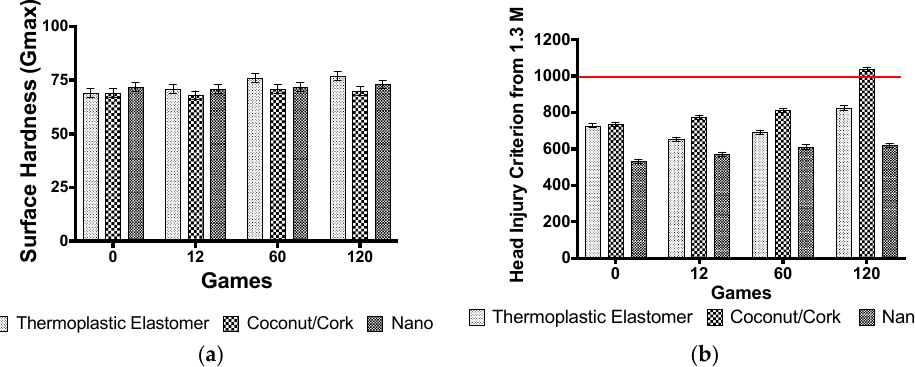
Figure 1. ( a ) Mean surface hardness values for three synthetic turf infills at four traffic levels 0, 12, 60, and 120 games ( b ) Head injury criterion (HIC) of three different infills as affected by four different traffic levels: 0, 12, 60, and 120 games with a drop heights of 1.3 m during 2017 in Knoxville, TN. The line at 1000 HIC where a severe head injury is likely. Error bars represent standard error of the mean. Surface hardness data was collected using the F355 A missile, while HIC was collected using the F355 E missile. Error bars represent standard error of the